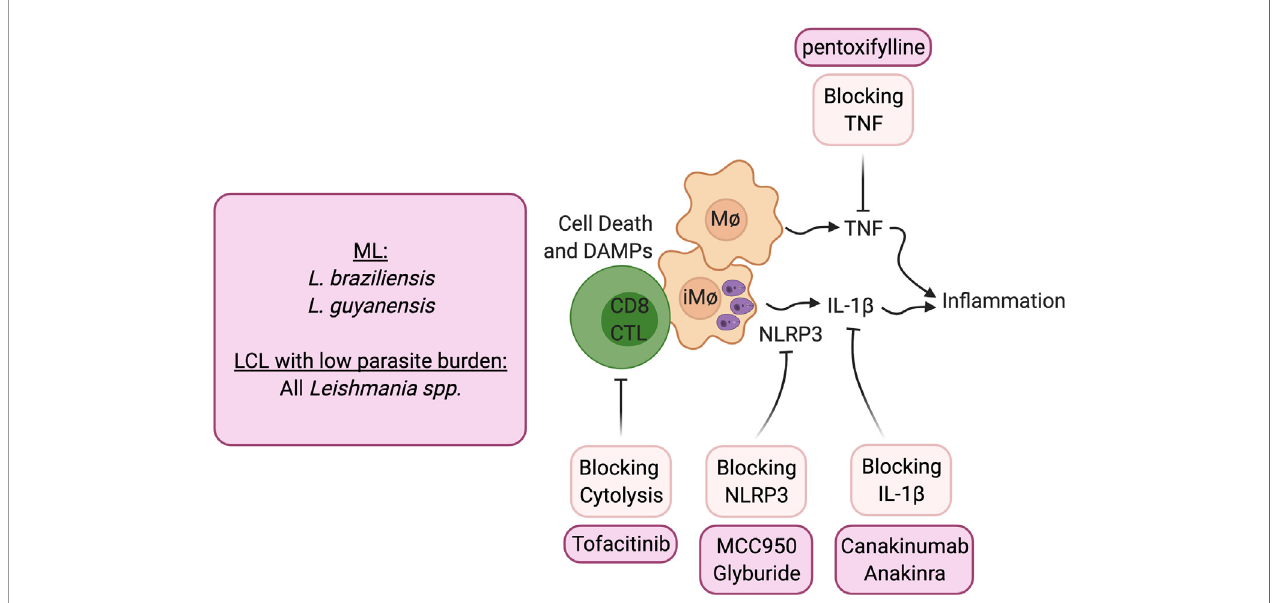
FIGURE 2 | Host directed therapies that block immunopathologic mediated cytolysis. ML, mucosal leishmaniasis; LCL, Localized cutaneous